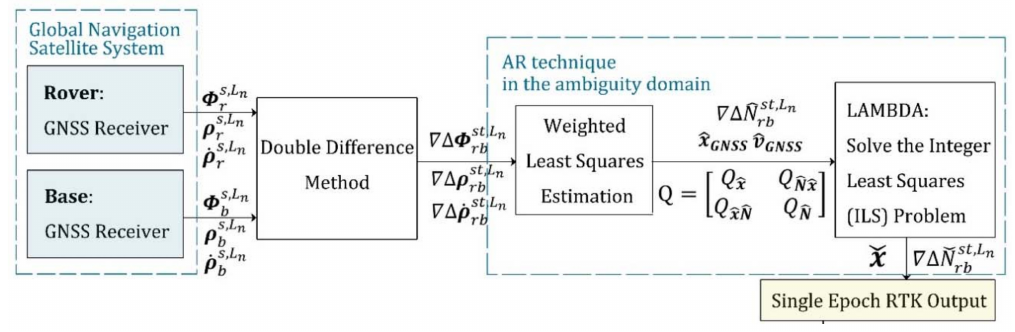
Figure 4. The implementation of single epoch